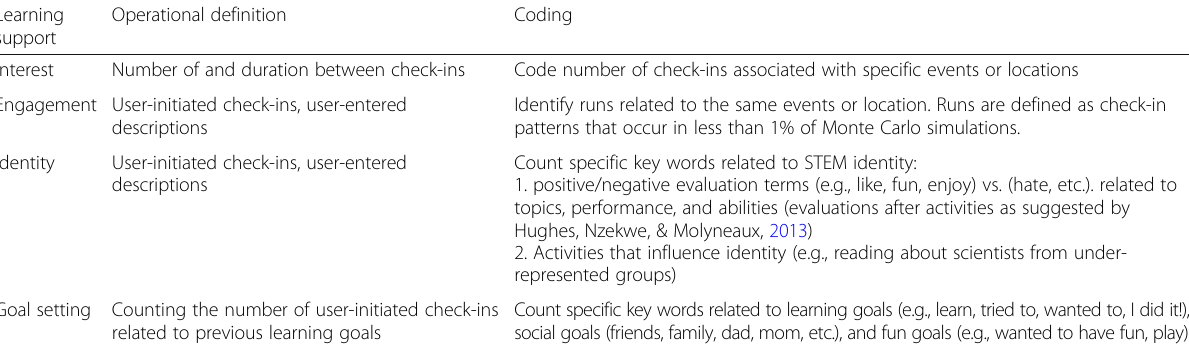
Table 2 Coding categories for behavioral constructs Learning Operational support